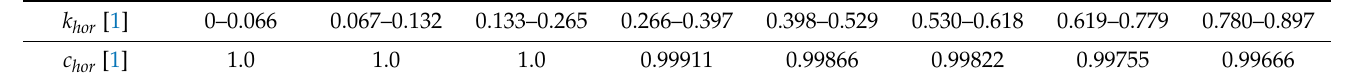
Table 1 defines the quotient k hor as half of the horizontal dimension of the photomontage. Table 1. Dependence of coefficient c hor on the interval of distance k hor .